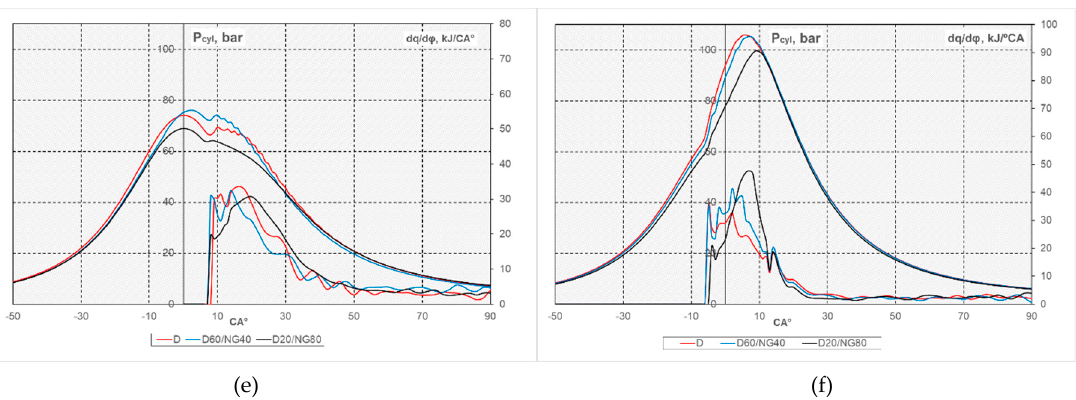
Figure 5. Combustion process indicator diagrams and heat release dynamics 𝑑𝑄 𝑑𝜑⁄ for different 𝜑 (cid:3036)(cid:3041)(cid:3037) (cid:3435)𝜑 (cid:3036)(cid:3041)(cid:3037) = −1 and − 13 °CA(cid:3439), (𝑛 = 2000 min (cid:2879)(cid:2869) ) : (a) and (b) correspond to LLM; (c) and (d) correspond to MLM; (e) and (f) correspond to HLM.